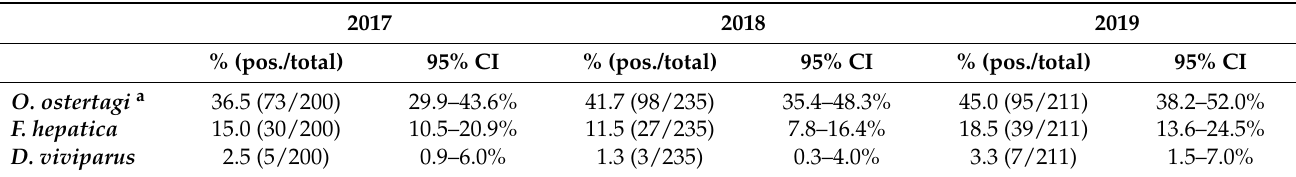
Figure 1. Distribution of O. ostertagi , F. hepatica and D. viviparus antibody level categories as assessed in BTM samples from three different parts of Germany from 2017–2019. The map shows the northern part (i.e., the federal states of Schleswig-Holstein and Lower Saxony) in blue, the eastern part (i.e., the federal states of Mecklenburg-Western Pomerania, Brandenburg, Thuringia, Saxony-Anhalt) in red and the southern part (i.e., the federal state of Bavaria) in green. Table 1. Annual variation in seroprevalence of major pasture-borne parasitoses in BTM samples from German dairy